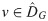
Simulation study results under the alternative hypothesis in scenario 2 (top panel), in scenario 3 (middle panel), and in scenario 4 (bottom panel).On the left, results based on the maximum likelihood estimate of the covariance matrix; on the right results based on the regularized estimate. Each subpanel corresponds to a different combination of sample size (columns) and intensity of dysregulation (rows). Inside subpanels, for each node v ∈ V, a stacked bar chart shows the percentage of Monte Carlo runs in which v∈D^G (red, primary set), v∈D^G\D^G (orange, secondary set) and v∈V\D^G (green). The Monte Carlo error is bounded above by 2.2%.